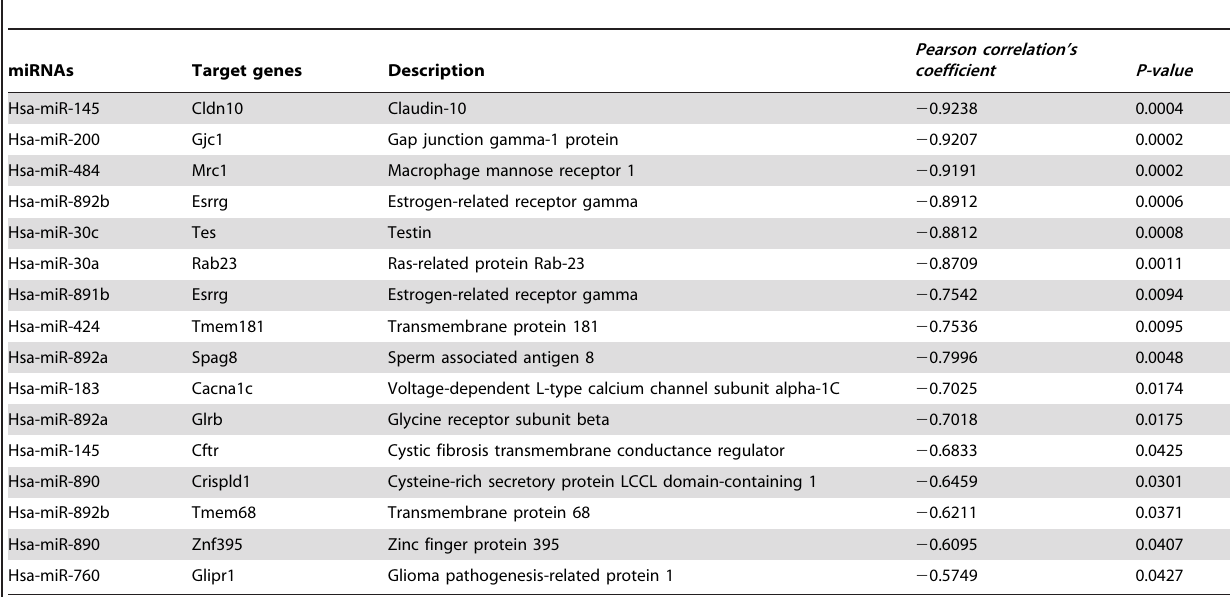
Table 3. List of selected miRNAs that displayed a negative correlation with their predicted target mRNAs.